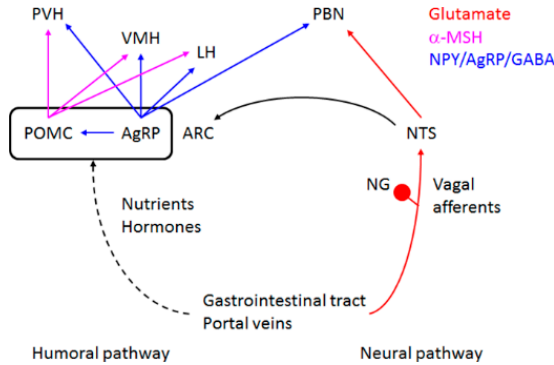
Figure 2. Circuits for homeostatic appetite control. Internal cues are conveyed by humoral and neural pathways and ultimately to the arcuate nucleus (ARC), where the information is integrated. ARC pro-opiomelanocortin (POMC) and agouti-related peptide (AgRP) neurons send projections to the secondary centers. Color of the projections depicts neurotransmitters used. LH, lateral hypothalamus; NG, nodose ganglion; NTS, solitary tract nucleus; PBN, parabrachial nucleus; PVH, paraventricular nucleus of the hypothalamus; VMH, ventromedial nucleus of the hypothalamus.